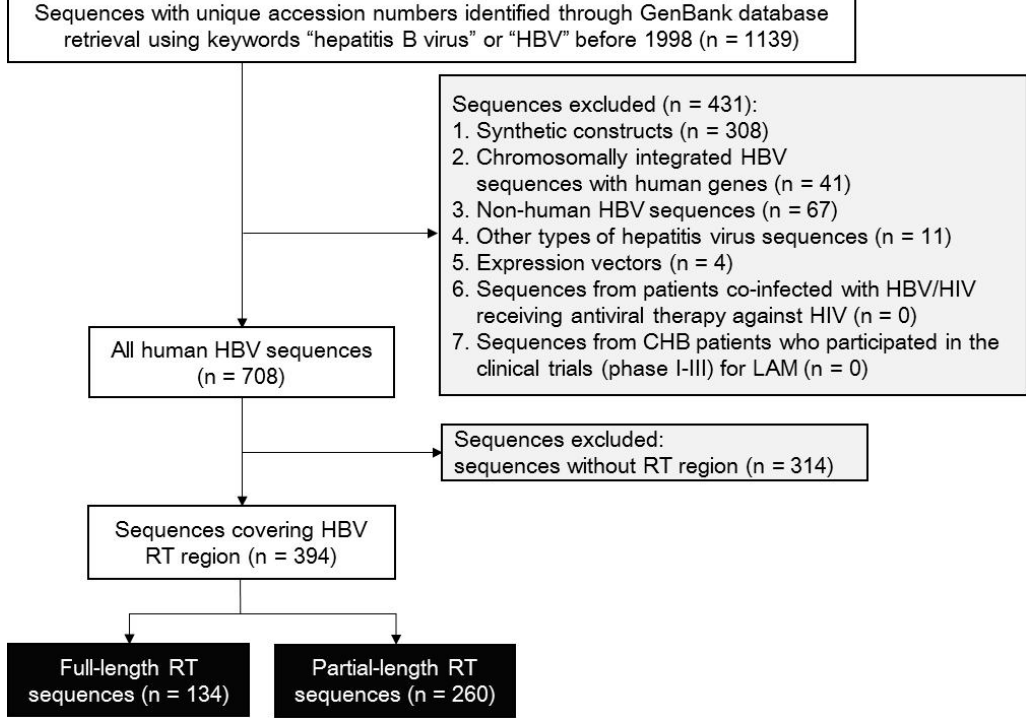
Figure 1. Flowchart showing the process of searching and screening for HBV RT sequences used in this study. The grey boxes show the excluded sequences, while the black boxes show those that qualified for analyses. CHB: chronic hepatitis B; HBV: hepatitis B virus; HIV: human immunodeficiency virus; LAM: lamivudine; RT, reverse transcriptase.